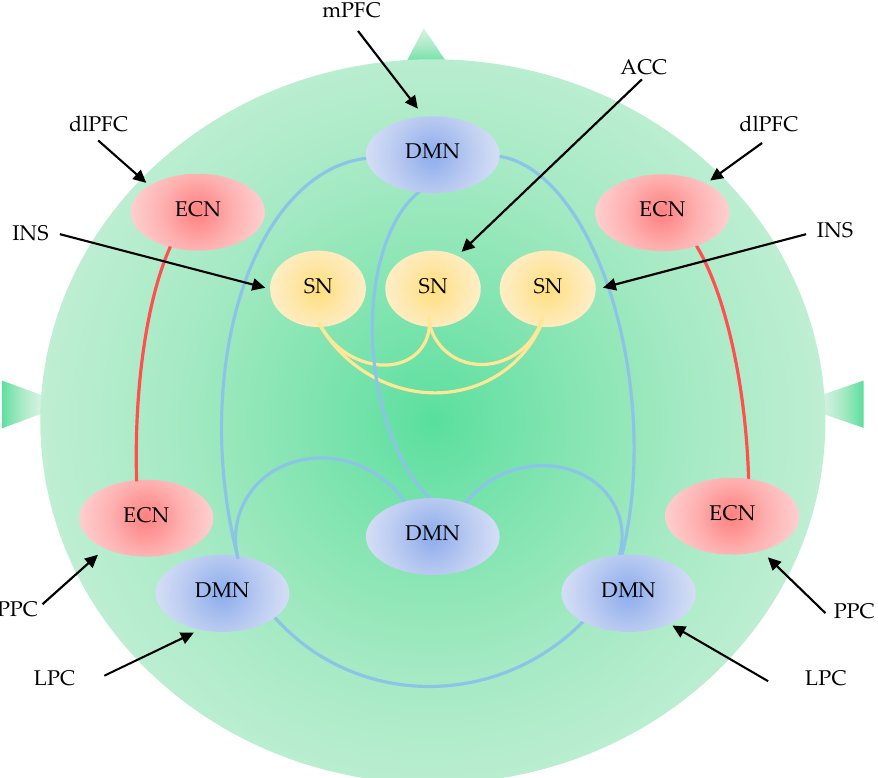
Figure 4. Large-scale brain network including the default mode network, the executive control network, and the salience network. DMN: default mode network; ECN: executive control network; SN: salience network; ACC: anterior cingulate cortex; dlPFC: dorsolateral prefrontal cortex; INS: insular cortex; LPC: lateral parietal cortex; mPFC: medial prefrontal cortex; PPC: posterior parietal cortex. A relative increase in DMN connectivity and significant ReHo reduction were ob- served in the posterior DMN of patients with late-life depression (LLD) [50–53]. ICA stud- ies revealed an increased connectivity within the anterior DMN of patients with depres- sion compared to healthy controls [54]. The dissociation between the anterior and poste- rior DMN subdivisions was observed in patients with major depressive disorder [55]. An- tidepressant treatment restored FC abnormality in the posterior DMN but did not correct the FC abnormality in the anterior DMN. Network homogeneity was increased in the an- terior DMN but decreased in the posterior DMN [56]. Seed-based analysis using mPFC showed the dissociation between the anterior and posterior DMN and increased connec- tivity between the anterior DMN and the salience network (SN) in depression [57,58]. De- creased PCC connectivity and increased connectivity in the anterior DMN were observed in depressive patients without medication and 12-weeks treatment of paroxetine partially restored the decreased connectivity [59]. In general, FC between PCC and left medial frontal gyrus decreased in patients with depression and 12-weeks of antidepressant treat- ment increased FC between PCC to the bilateral medial frontal gyrus [60]. Psychedelics are known to disrupt the activity of the DMN. Serotonergic psychedelic psilocybin-as- sisted therapy significantly reduced the depression scores of patients with severe depres- sion [61]. The Executive Control Network